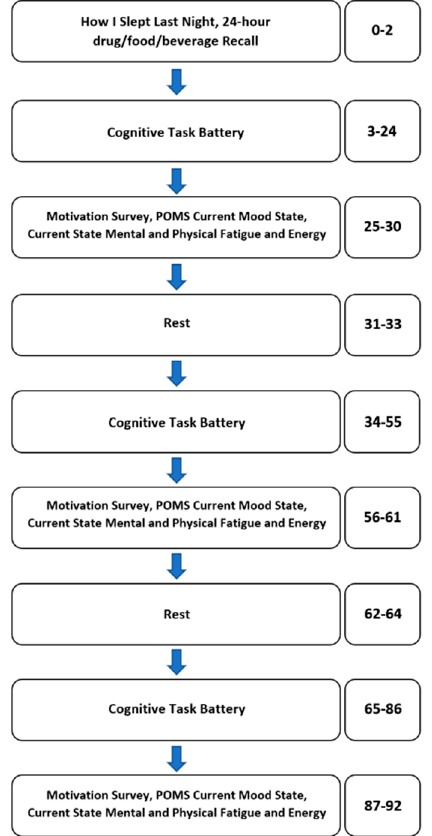
Figure 2. Task and Time. Note: Completion times of each task are means of the participants. Rest times were a standard 2 min for all participants.